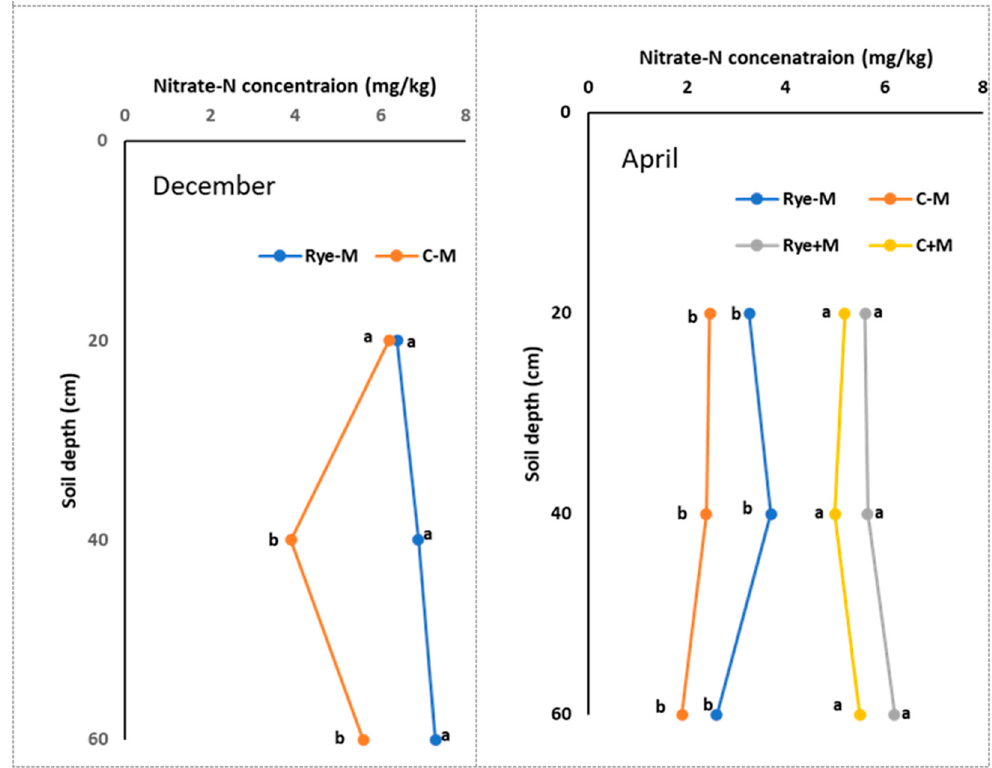
Figure 4. Nitrate-N levels in soil profile as affected by manure application and cover crop. Letters note separation of means by Duncan’s New Multiple Range Test, P = 0.05. Date of soil sampling (April) and (December). Rye cover crop added manure (Rye + M), Rye cover crop with no manure (Rye-M), No cover crop with added manure (C + M) and no cover crop with no manure (C − M).